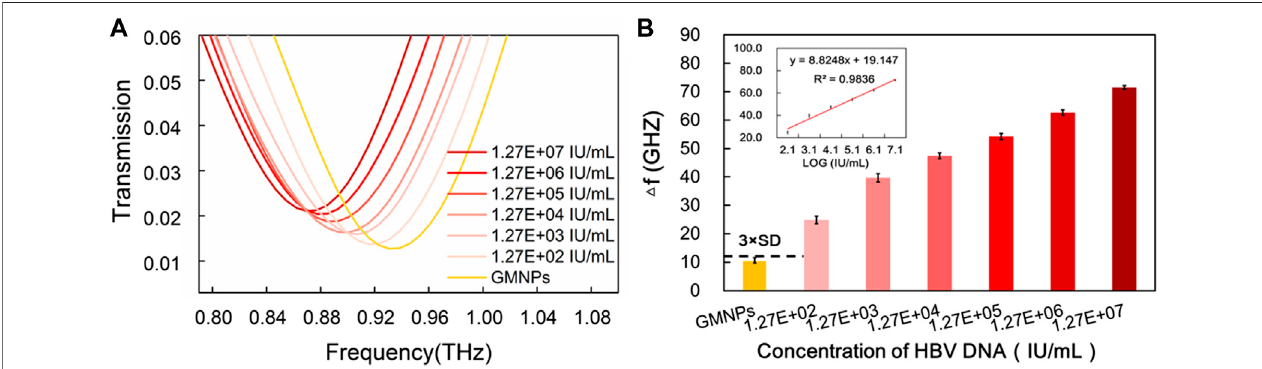
FIGURE5 | Sensitivity ofTHz biosensing strategy for HBV DNA detection in serum sample. (A) The frequenciesof THztransmissionspectra for blankGMNPsand GMNPs-RCA-AuNPs ampli fi ed with different concentrations of the HBV DNA. (B) The THz frequencies shifts ( Δ f ) for blank GMNPs and GMNPs-RCA-AuNPs ampli fi ed with different concentrations of the HBV DNA. Error bars indicate the SD ( n = 3). The inset graph shows the linear fi t of the frequencies versus the logarithm of the HBV DNA concentration. The error bars indicate the SD ( n =